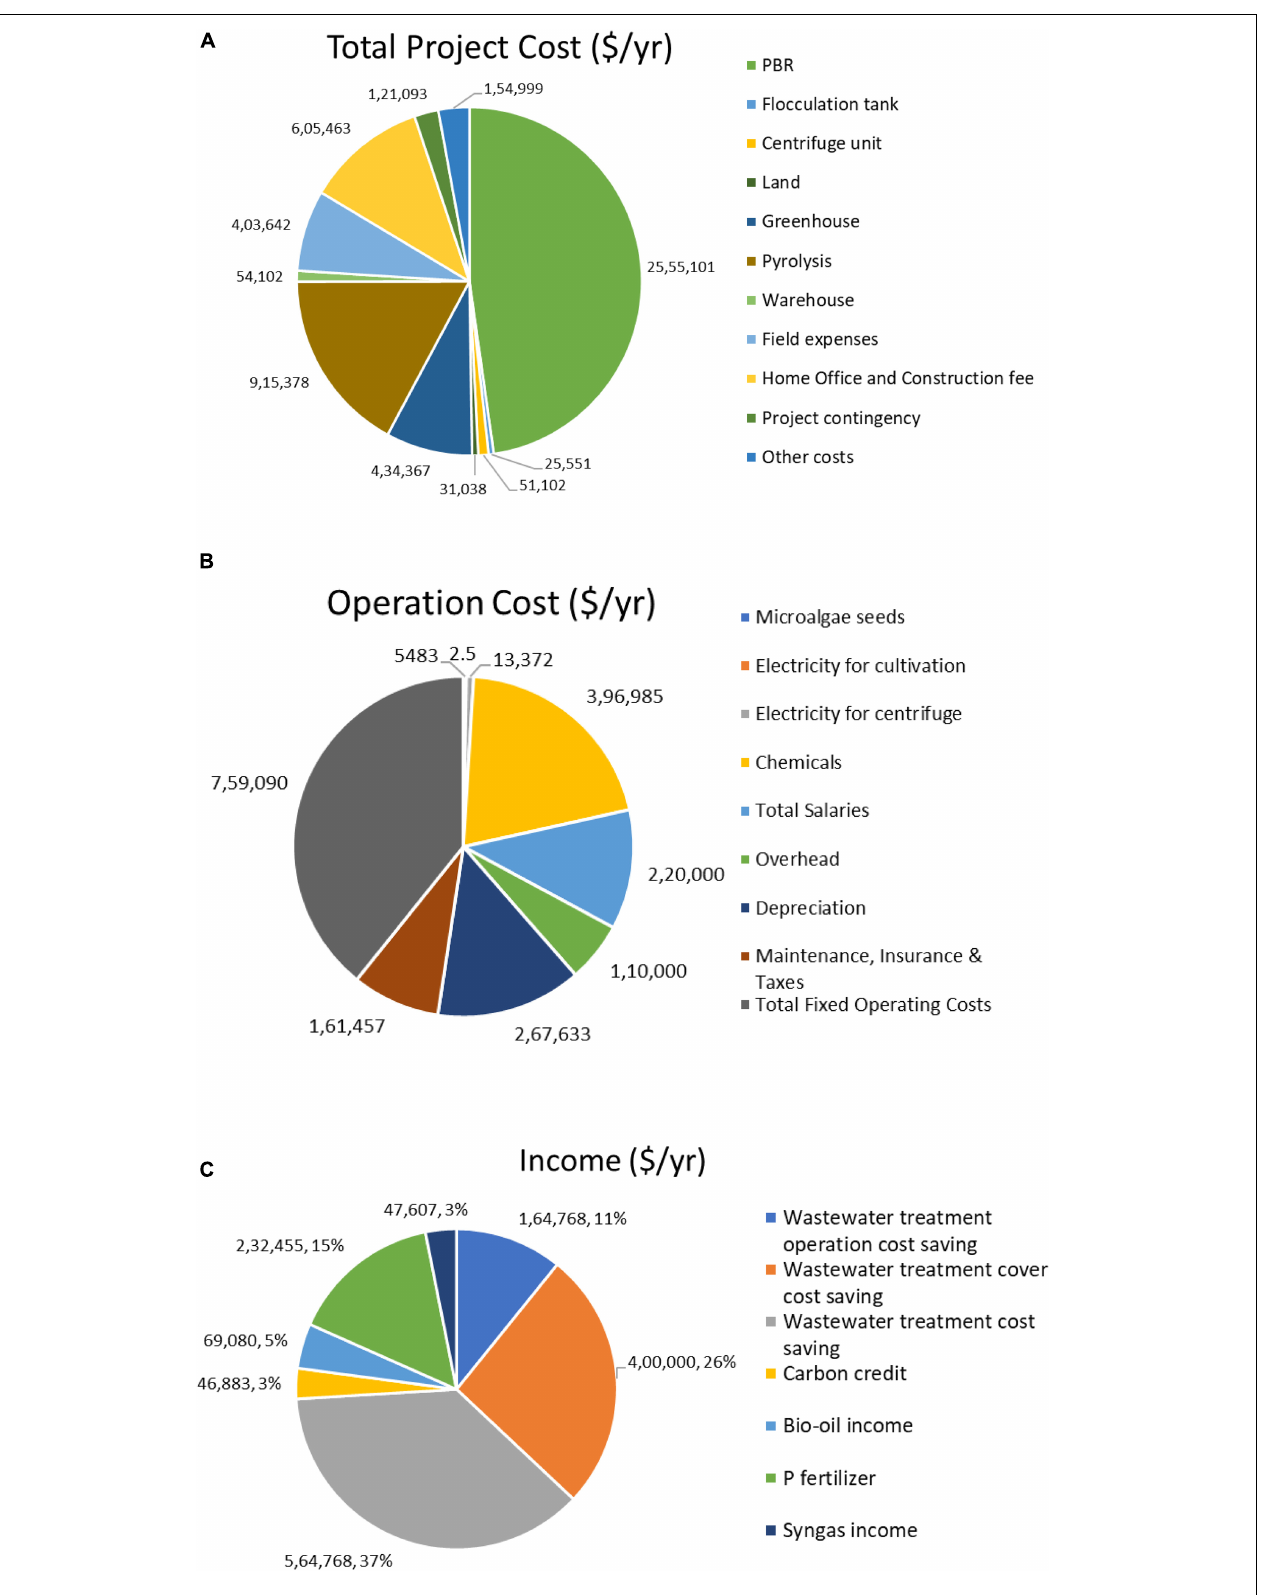
FIGURE 5 | Distribution of costs and income per year (A) Distribution of capital costs; (B) Distribution of operation costs; (C) Distribution of income (Xin et al., 2016).